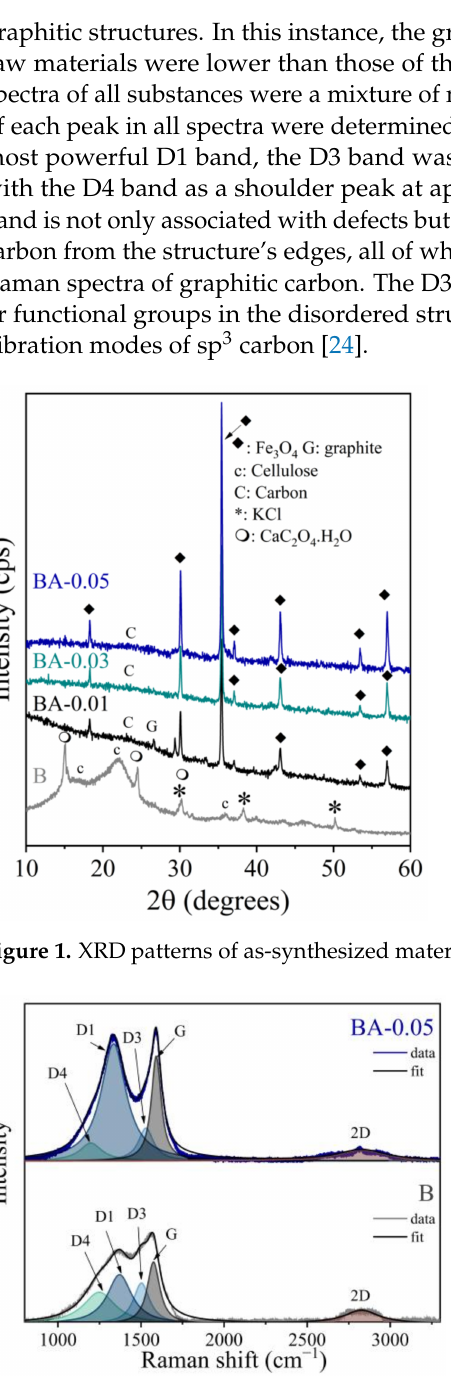
Figure 2. Raman spectra of selected BA-0.05 nanocomposite and raw materials (B). D1–D3 and G explained in the